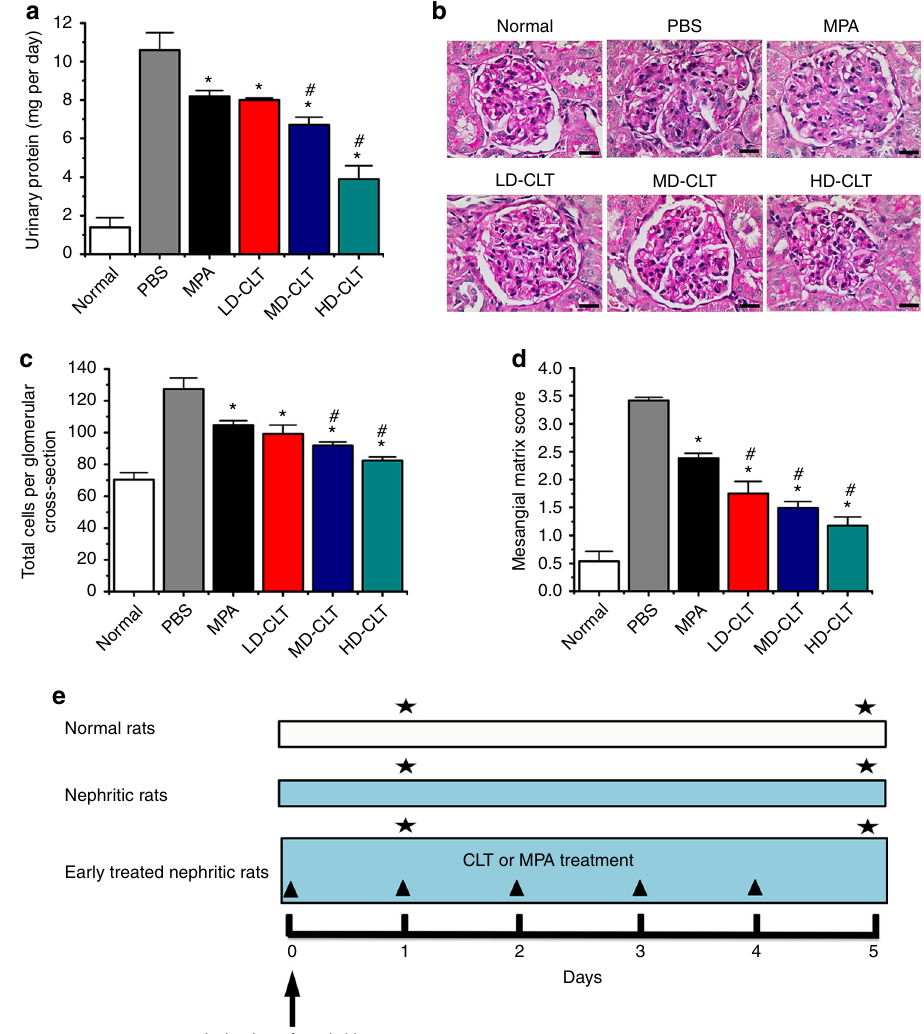
Fig. 1 Early CLT treatment shows dose-dependent ef fi cacy in the reversible model. a Effects of MPA (30 mg kg − 1 ) and CLT (LD-CLT, 1 mg kg − 1 ; MD-CLT, 2 mg kg − 1 ; HD-CLT, 3 mg kg − 1 ) on 24-h urinary protein excretion in anti-Thy1.1 nephritic rats on day 5 after disease induction. b Glomerular histology revealed by PAS staining of kidney tissue sections from anti-Thy1.1 nephritic rats on day 5 after early treatment with MPA or different doses of CLT. Scale bars , 20 μ m. c Effects of MPA and different doses of CLT on total glomerular cellularity on day 5 after disease induction. For each animal group, 150 glomeruli were selected and total glomerular cells were counted using cellSens Standard digital imaging software (Olympus). d Effects of MPA and different doses of CLT on ECM accumulation on day 5 after disease induction. For each animal group, 150 glomeruli were analyzed and ECM deposition was graded semiquantitatively as described in Methods. In panels a , c , and d data are mean ± s.d. ( n = 5), results are representative of two independent experiments. * P < 0.05 vs. PBS group; # P < 0.05 vs. MPA group. Statistical signi fi cance was determined by one-way ANOVA with Tukey post hoc test. e Flow diagram of the early treatment of CLT or MPA against the reversible anti-Thy1.1 nephritis. Black triangle denotes intravenous treatment of CLT or MPA; black star denotes time points of nephrectomy while respective animals were sacri fi ced. A detailed description is given in